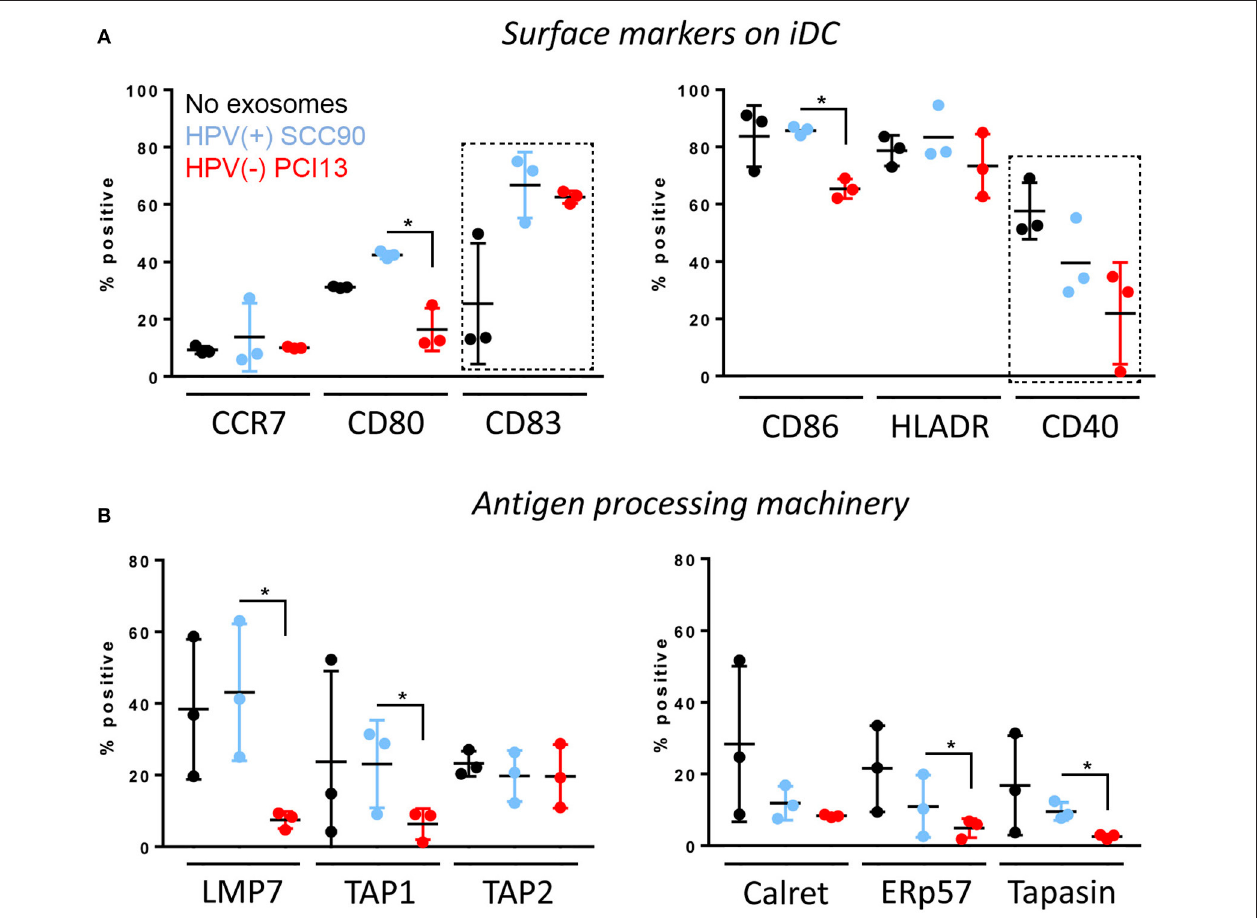
FIGURE 6 | Effects of HPV( + ) and HPV( − ) exosomes on immature human dendritic cells (iDC). Co-incubation of HPV( + ) or HPV( − ) exosomes with human PBMC-derived monocytes. The exosomes were added to monocytes on days 0 and 3 of culture as described in Methods. iDC were harvested on day 6 and were studied by flow cytometry for expression levels of co-stimulatory proteins on the cell surface in (A) or the APM components in the cytoplasm in (B) . The data are from 3 experiments performed with iDCs generated from monocytes of 3 healthy donors. Stars denote significant differences between HPV( + ) and HPV( − ) exosomes at p < 0.05. Dotted squares indicate differences at p < 0.05 between iDC + no exosomes vs. iDC co-incubated with either HPV( + ) or (HPV( − ) exosomes). All other differences between HPV( + ) and HPV( − ) exosomes are